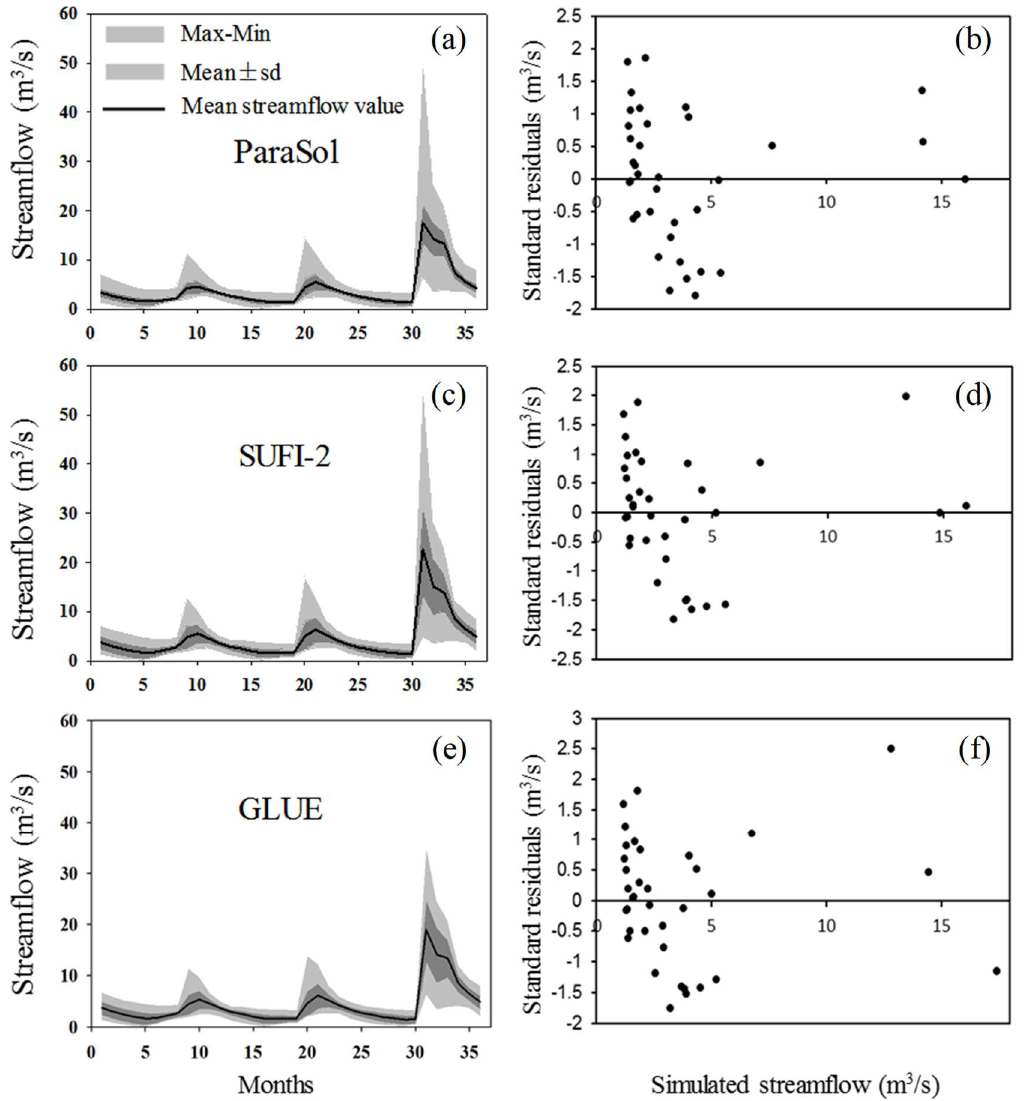
Figure 6. Sensitivity range of monthly streamflow (left column) based on the parameter distribution as generated by ParaSol ( a ), SUFI2 ( c ) and GLUE ( e ) during the 3-year calibration (2008–2010), sd refers to the standard deviation of the model response. The light grey shade by Mine-Max represents the minimum and maximum model response at each time step, whereas the dark grey shade by Mean ± sd refers to the mean model response plus/minus one standard deviation. The right column indicates the standard residuals versus simulated streamflow obtained from ParaSol ( b ), SUFI2 ( d ) and GLUE ( f ) during the calibration period.